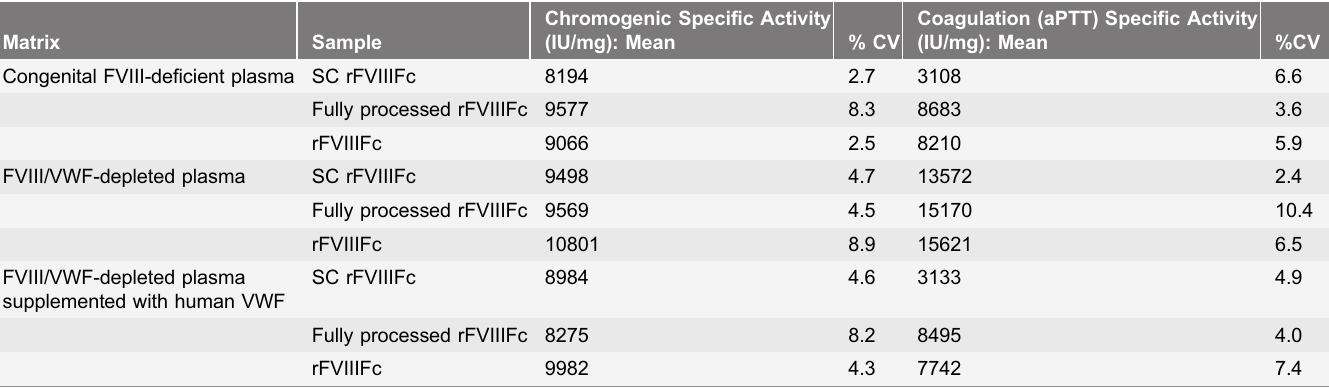
Table 1. Specific activity of SC rFVIIIFc compared to fully processed rFVIIIFc and rFVIIIFc by chromogenic and one-stage (aPTT) assays (n 5 3). Matrix